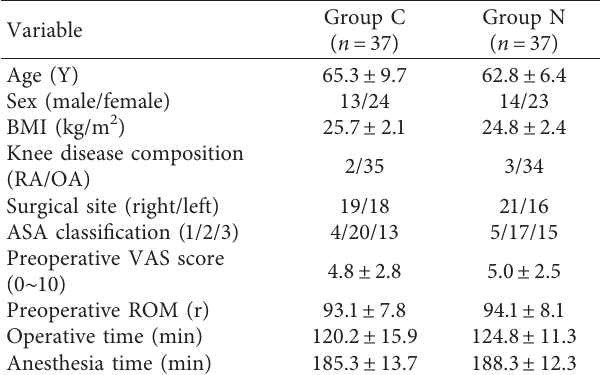
Figure 1: CONSORT diagram. Flow diagram of patients assessed using the protocol. FNB � femoral nerve block. Table 1: Patient demographics and operative